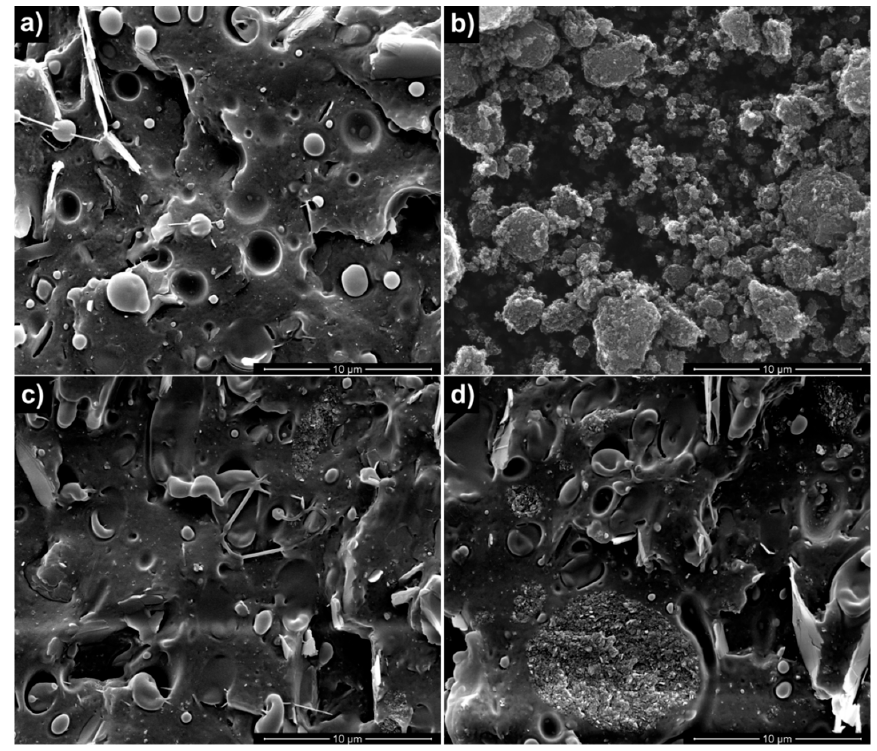
Figure 1. SEM micrographs of: ( a ) BIO; ( b ) neat GnP; ( c ) BIO/GnP-1; ( d ) BIO/GnP-5.